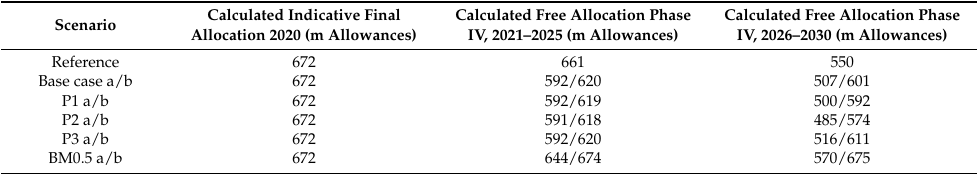
Table 3. Calculated annual free allocation in Phase IV under the EU Emissions Trading System (ETS). Scenario